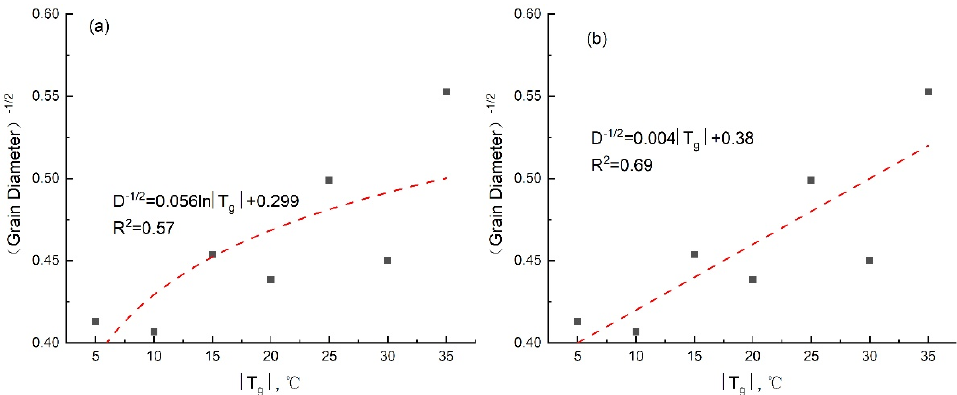
Figure 14. Grain size versus growth temperature and curves fitted with different function types. Solid squares are test data. Dashed lines are fitted curves. ( a ) is a logarithmic function and ( b ) is a linear function. Fitting equations and correlation coefficients are given.